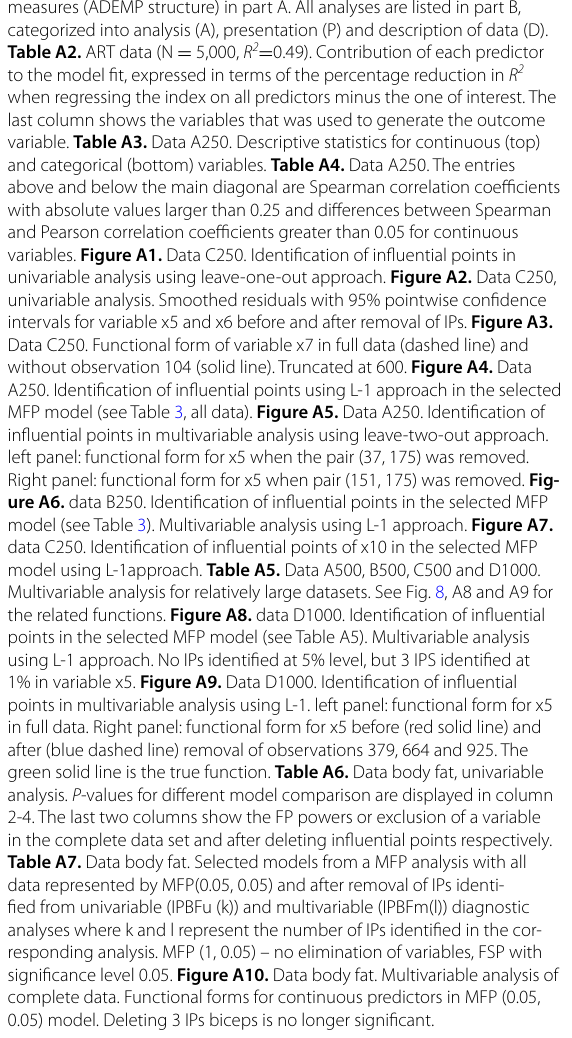
Table A7. Data body fat. Selected models from a MFP analysis with all data represented by MFP(0.05, 0.05) and after removal of IPs identi- fied from univariable (IPBFu (k)) and multivariable (IPBFm(l)) diagnostic analyses where k and l represent the number of IPs identified in the cor- responding analysis. MFP (1, 0.05) – no elimination of variables, FSP with significance level 0.05. Figure A10. Data body fat. Multivariable analysis of complete data. Functional forms for continuous predictors in MFP (0.05, 0.05) model. Deleting 3 IPs biceps is no longer